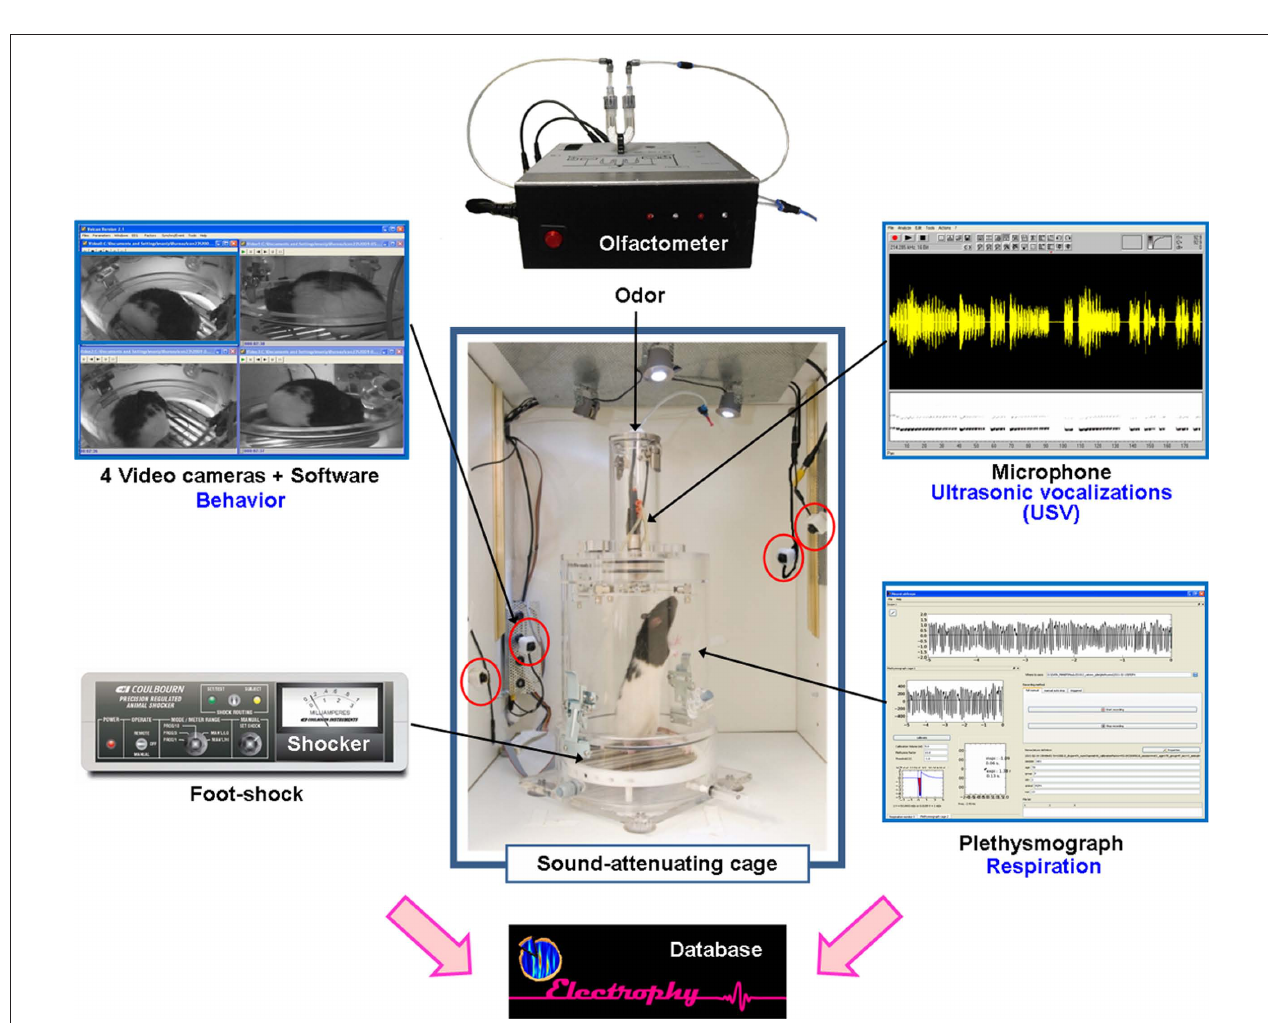
vocalizations (USV) emitted by the rats. Animals’ behavior was monitored using four video cameras placed at each corner of the sound-attenuating cage. The bottom of the plethysmograph was equipped with a floor connected to a shocker to deliver foot-shocks. The collected data were entered in a database (OpenElectrophy) for offline synchronization